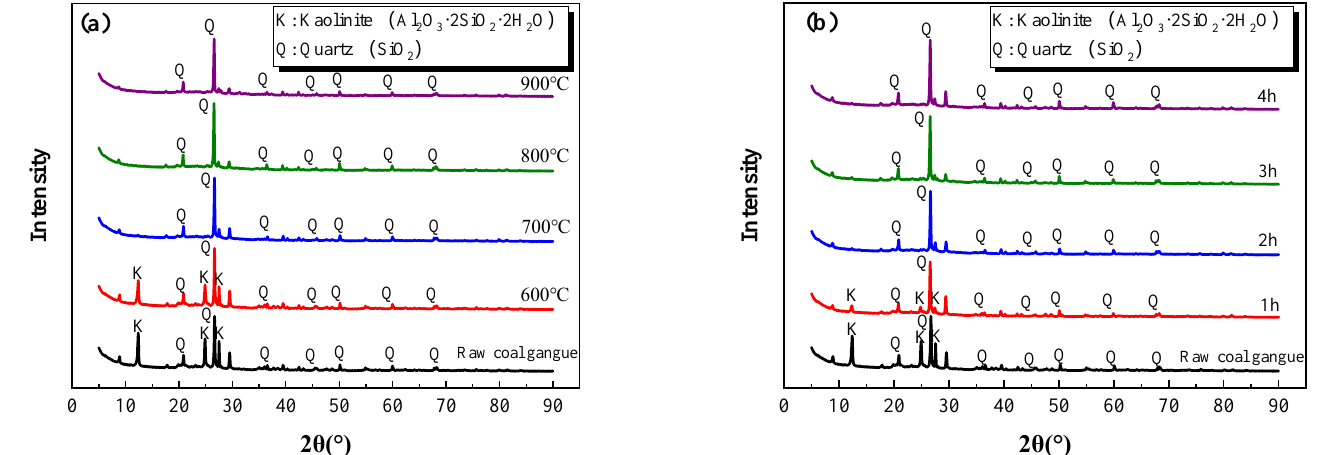
Figure 5. XRD patterns at different calcination temperatures ( a ) and holding times ( b ).